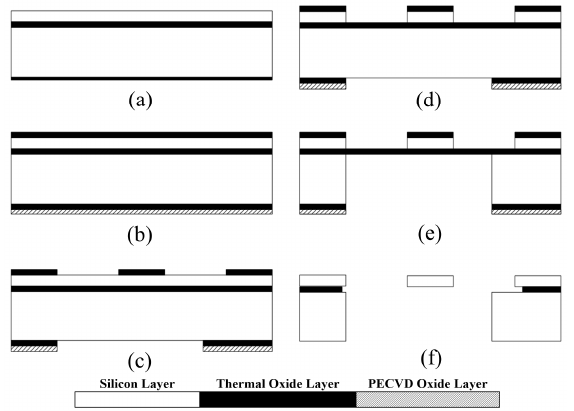
Figure 3. Fabrication process of the multi-mode energy harvester. ( a ) SOI wafer; ( b ) thermal oxide growth and plasma-enhanced chemical vapor deposition (PECVD) oxide deposition on the backside; ( c ) Photoresist patterning and oxide etching by reactive ion etching (RIE); ( d ) silicon device layer